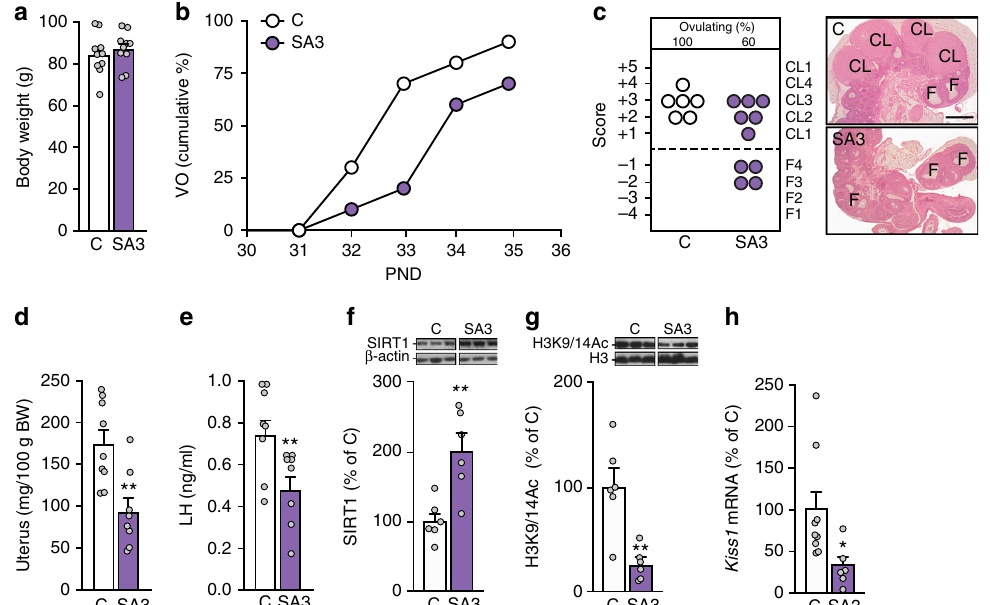
Fig. 4 Central pharmacological activation of SIRT1 delays pubertal timing. Indices of somatic/pubertal maturation in immature female rats following central, pharmacological SIRT1 activation by the allosteric SIRT1-activator, SA3, are shown. a Body weight of controls (C; white bars) and SA3-treated (bars in violet) rats. b Cumulative percent of C and SA3-treated rats showing vaginal opening (VO). c Histological score of follicular development/ovulation and representative images of ovarian maturation; CL: corpus luteum, F: follicle. d Uterine weight. e Serum LH levels. f Hypothalamic SIRT1 content. g Hypothalamic H3K9/14Ac content. h Kiss1 mRNA levels. The bar histograms represent the mean ± SEM. * p < 0.05; ** p < 0.01 (two-sided Student ’ s t test). For protein analyses in panels f and g , three representative bands per group, run in the same original western blots are presented. The scale bar in panel c corresponds to 600 μ m. Total group sizes were: C = 10 and SA3 = 10; while phenotypic and hormonal parameters were assayed in the whole groups (in the case of LH levels, for all serum samples that were available), hypothalamic protein ( f , g ) and RNA ( h ) analyses were conducted in a representative subset of randomly assigned samples from each group, with the following distribution: C: n = 6 − 8 (protein and RNA, respectively); SA3: n =